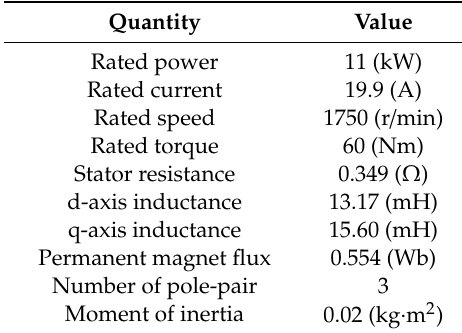
Table 2. IPMSM Table 2. IPMSM Parameters.